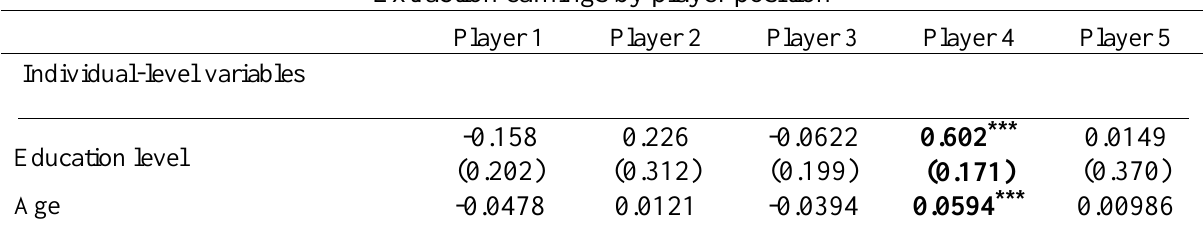
Table A4.3. Mixed effects regression models explaining the total tokens earned from water extraction by player position (coefficients with robust standard errors in parentheses; * p < 0.1, ** p < 0.05, *** p <